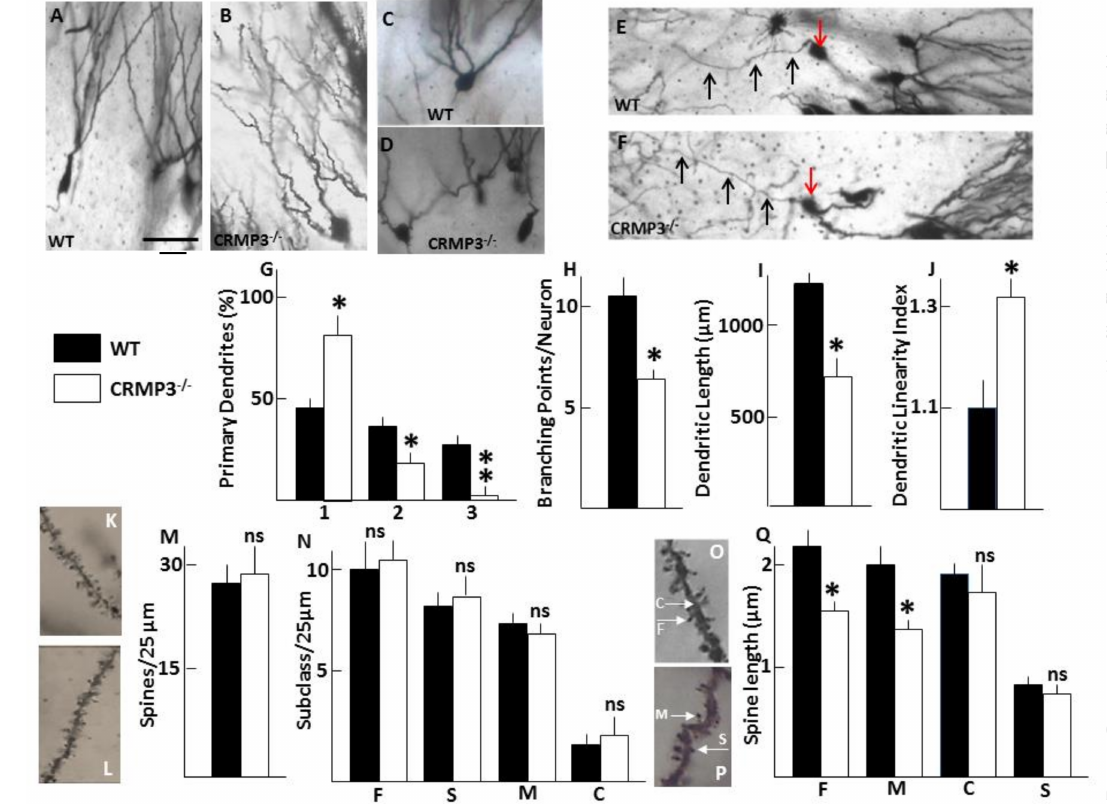
Figure 2. Morphometric analysis of dendrites and spines of granular neurons in adult CRMP3 − / −